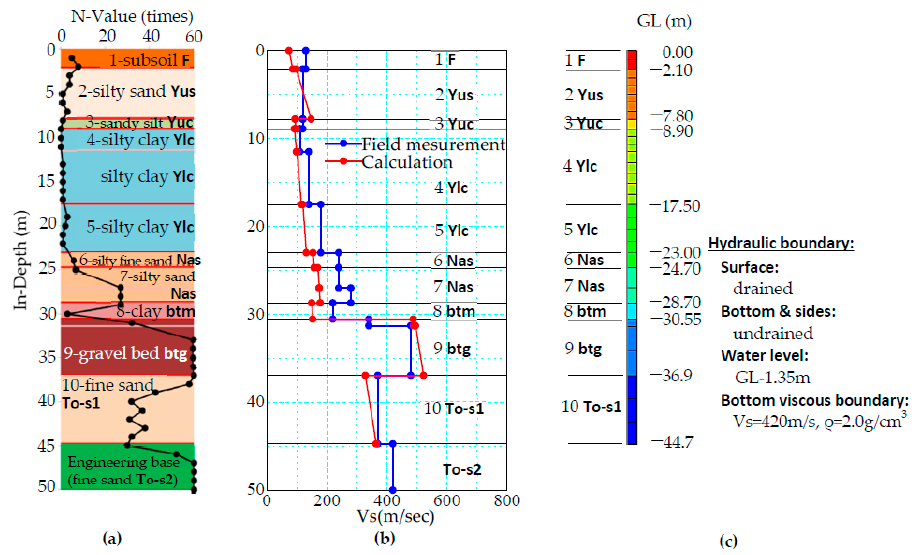
Figure 1. Soil boring log and 1D FE mesh with boundary conditions: ( a ) soil log; ( b ) shear wave velocity comparison; ( c ) FE mesh and BCs. Figure 2. 3D FE mesh of ground and holder foundation. 450m 44.75m